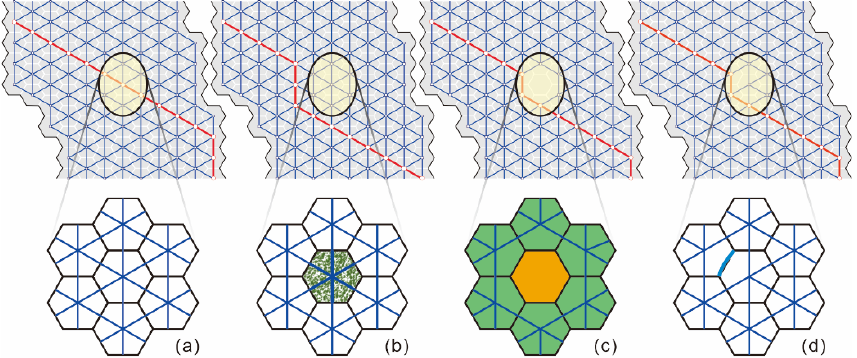
Figure 18. Application of path planning based on the grid models: ( a ) no terrain attribute influence, ( b ) influence of the grid element attributes, ( c ) influence of terrain characteristics, and ( d ) influence of the grid edge attributes.